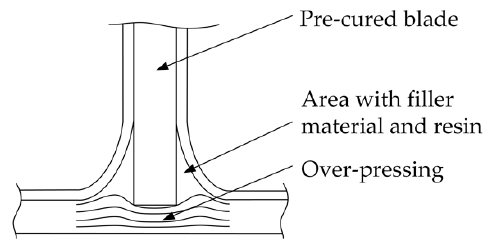
Figure 12. Example of co-bonding of a pre-cured stringer onto wet face layers leading to fiber waviness due to non-uniform consolidation pressure distribution.